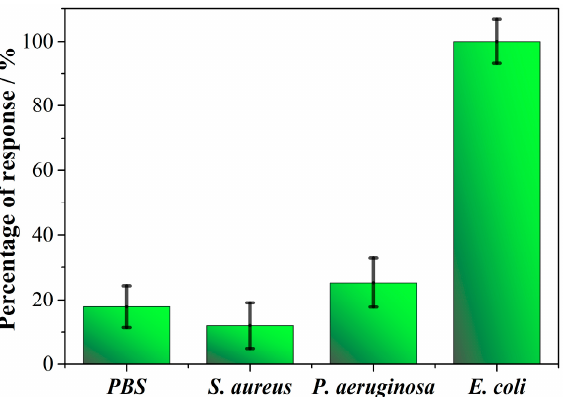
Figure 10. Selectivity results of the biosensor towards the detection of 50 CFU/mL of E. coli , S. aureus and P. aeruginosa bacteria.